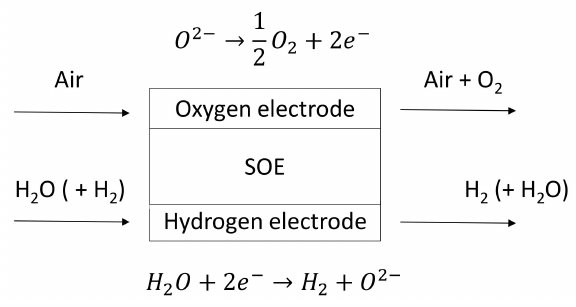
Figure 3. Scheme of a solid oxide